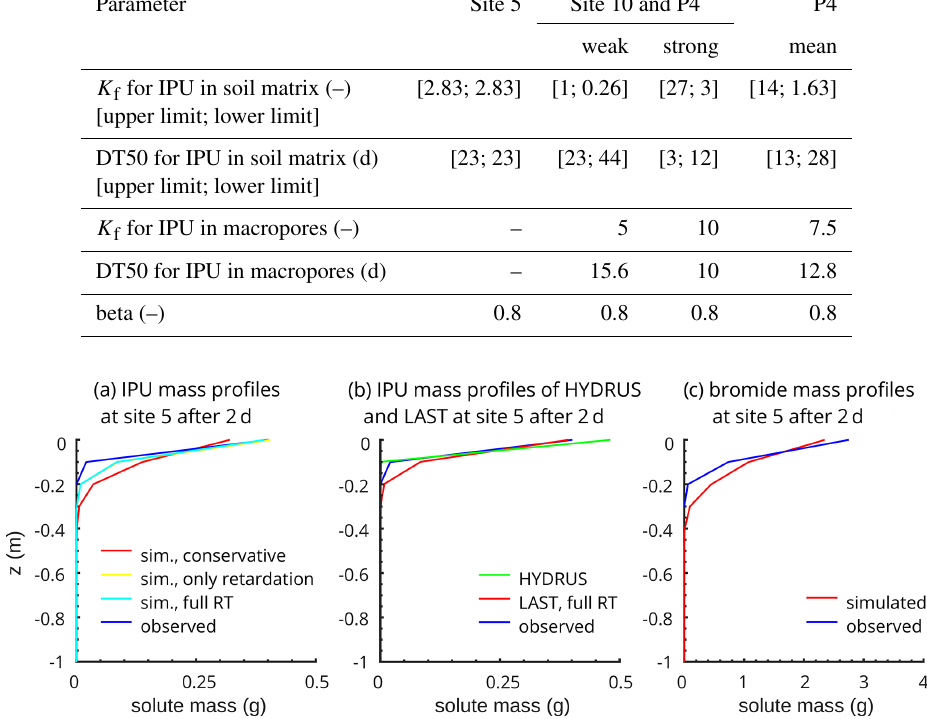
Figure 4. (a) LAST-Model results of reactive IPU transport simulations at the well-mixed site (site 5) after 2d with regarding IPU as con- servative without reactive transport which serves as reference (red profile), with activated retardation but without degradation to exclusively show the effect of the sorption processes (yellow profile) and with fully activated reactive transport (light blue profile). (b) Comparison with HYDRUS 1-D results and (c) exemplary results of a conservative simulation with LAST for